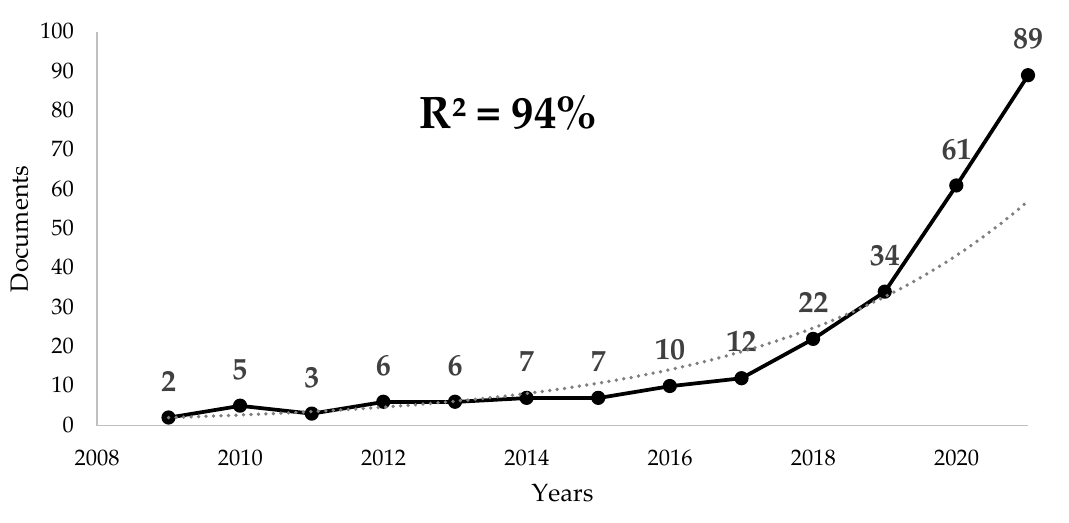
Figure 1. Annual publications trend on virtual reality and physical activity. R2: exponential growth rate.